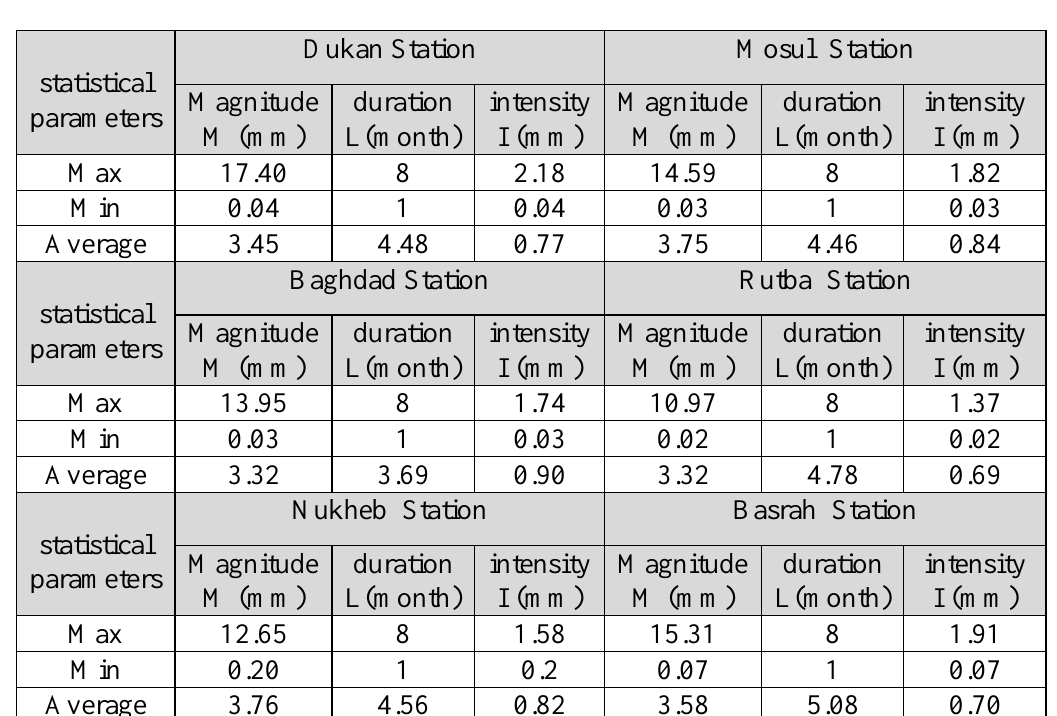
Fig. 3: SPI time series Rutba and Nukheb stations. Table 2: Statistical values of drought magnitude (M), duration (L), and intensity